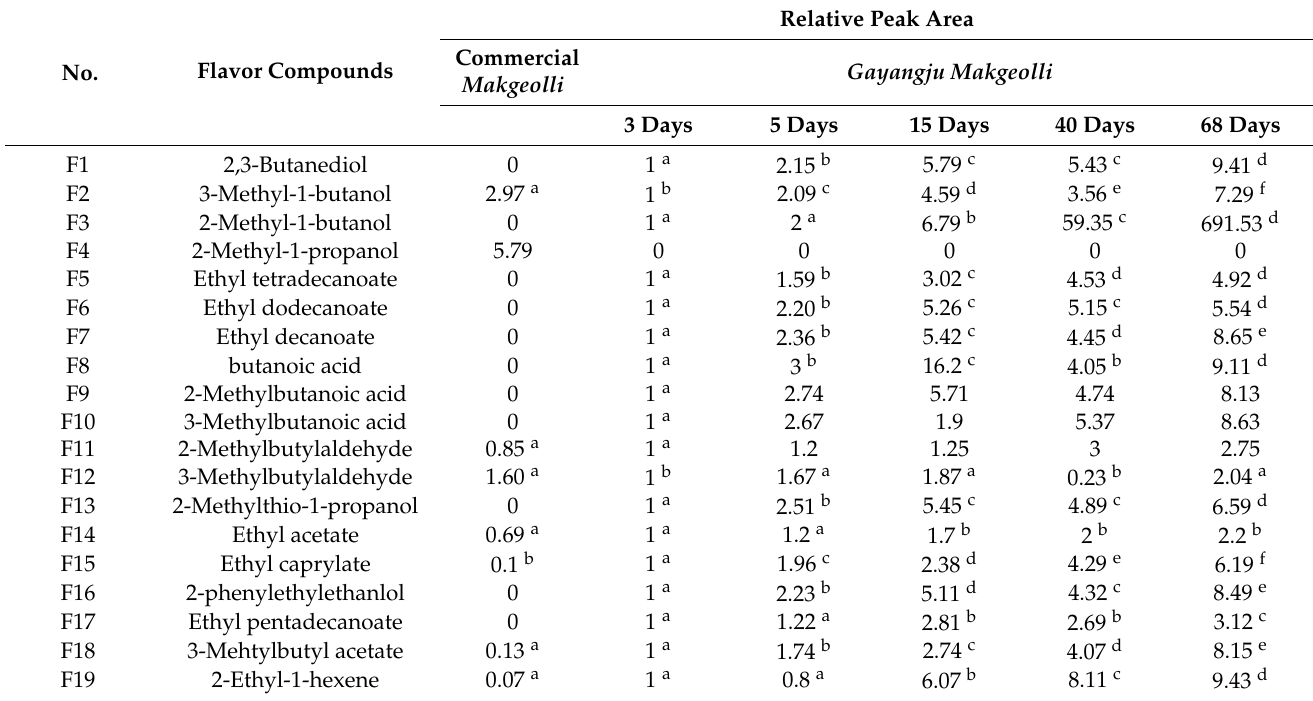
Table 1. Changes in volatile flavor compounds in Gayangju fermentation.